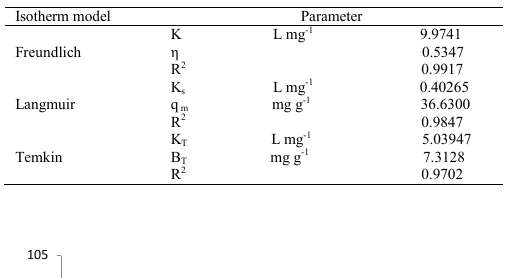
Table 2: Isotherm models for Hg(II) sorption onto nanocomposite